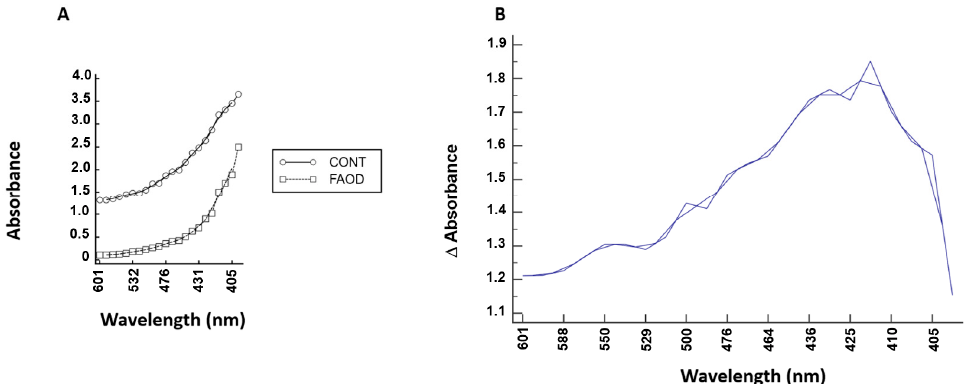
Figure 3 . ( A ) Absorbance of a human lens following topical FAOD treatment. Absorbance values plotted in function of wavelength (FAOD: treated lens; control: untreated lens of the same person). ( B ) Absorbance change in function of wavelength. The net difference in absorbance (absorbance untreated—absorbance treated) is plotted against the